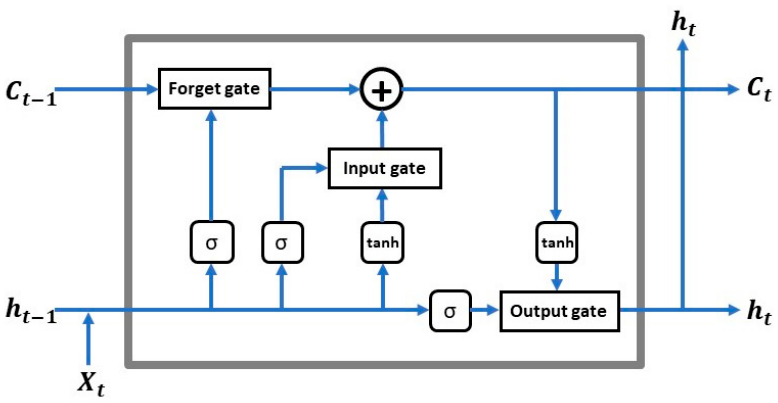
Figure 6. The inner structure of an LSTM cell.